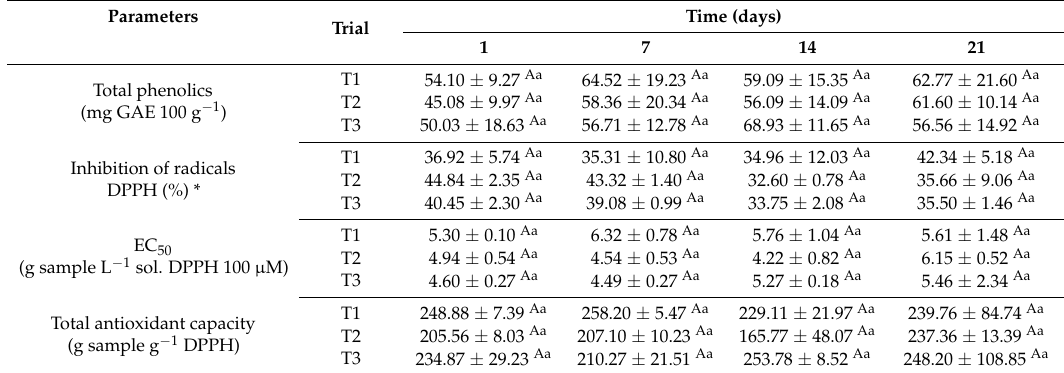
Table 4. Total phenolic content, percent inhibition of DPPH radicals, EC 50 and total antioxidant capacity of fermented dairy dessert trials containing jabuticaba peel ingredients after 1, 7, 14 and 21 days of storage at 4 ± 1 ◦